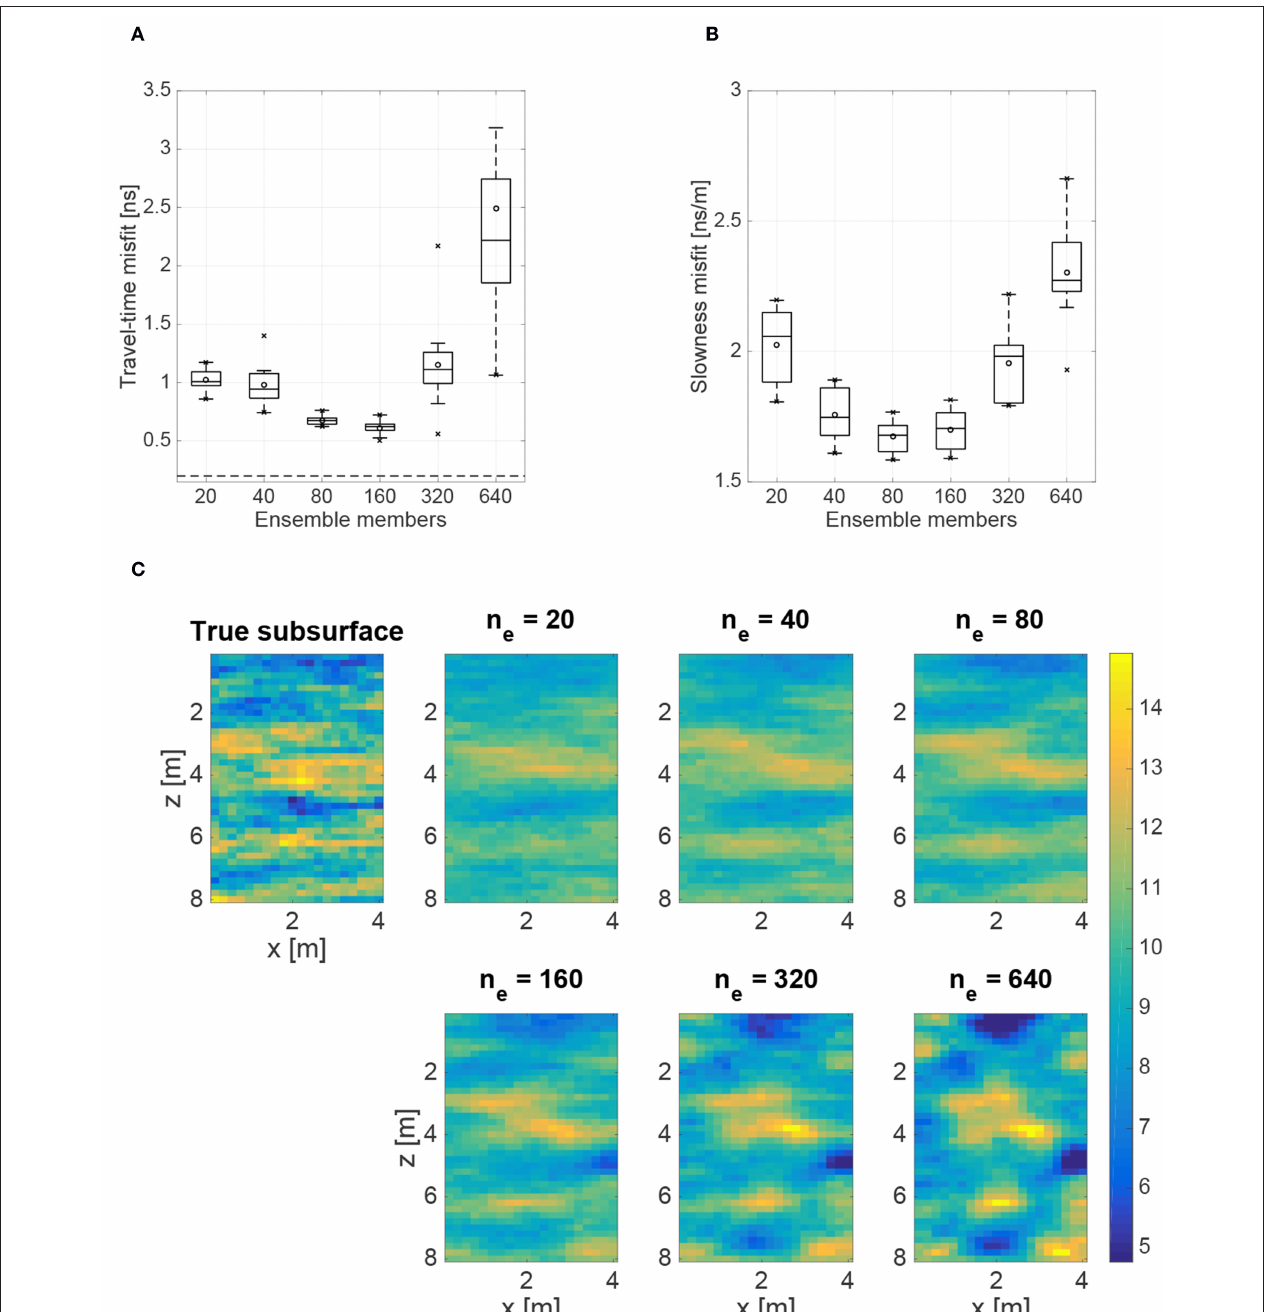
FIGURE 4 | Results of 10 runs of our modified ES-MDA algorithm to account for model error, with 20 detailed solver calculations and 20 KNN. Shown as a function of the number of ensemble members, n e , are (A) box plots of the average RMS travel-time misfit [ns]; (B) box plots of the average RMS slowness misfit [ns/m]; and (C) the mean posterior slowness fields [ns/m]. Added to the box plots are the mean (circles), and minimum and maximum values (crosses). The dashed horizontal line in (A) represents the expected value of the travel-time misfit assuming that the residuals follow the prescribed Gaussian distribution for the data errors.